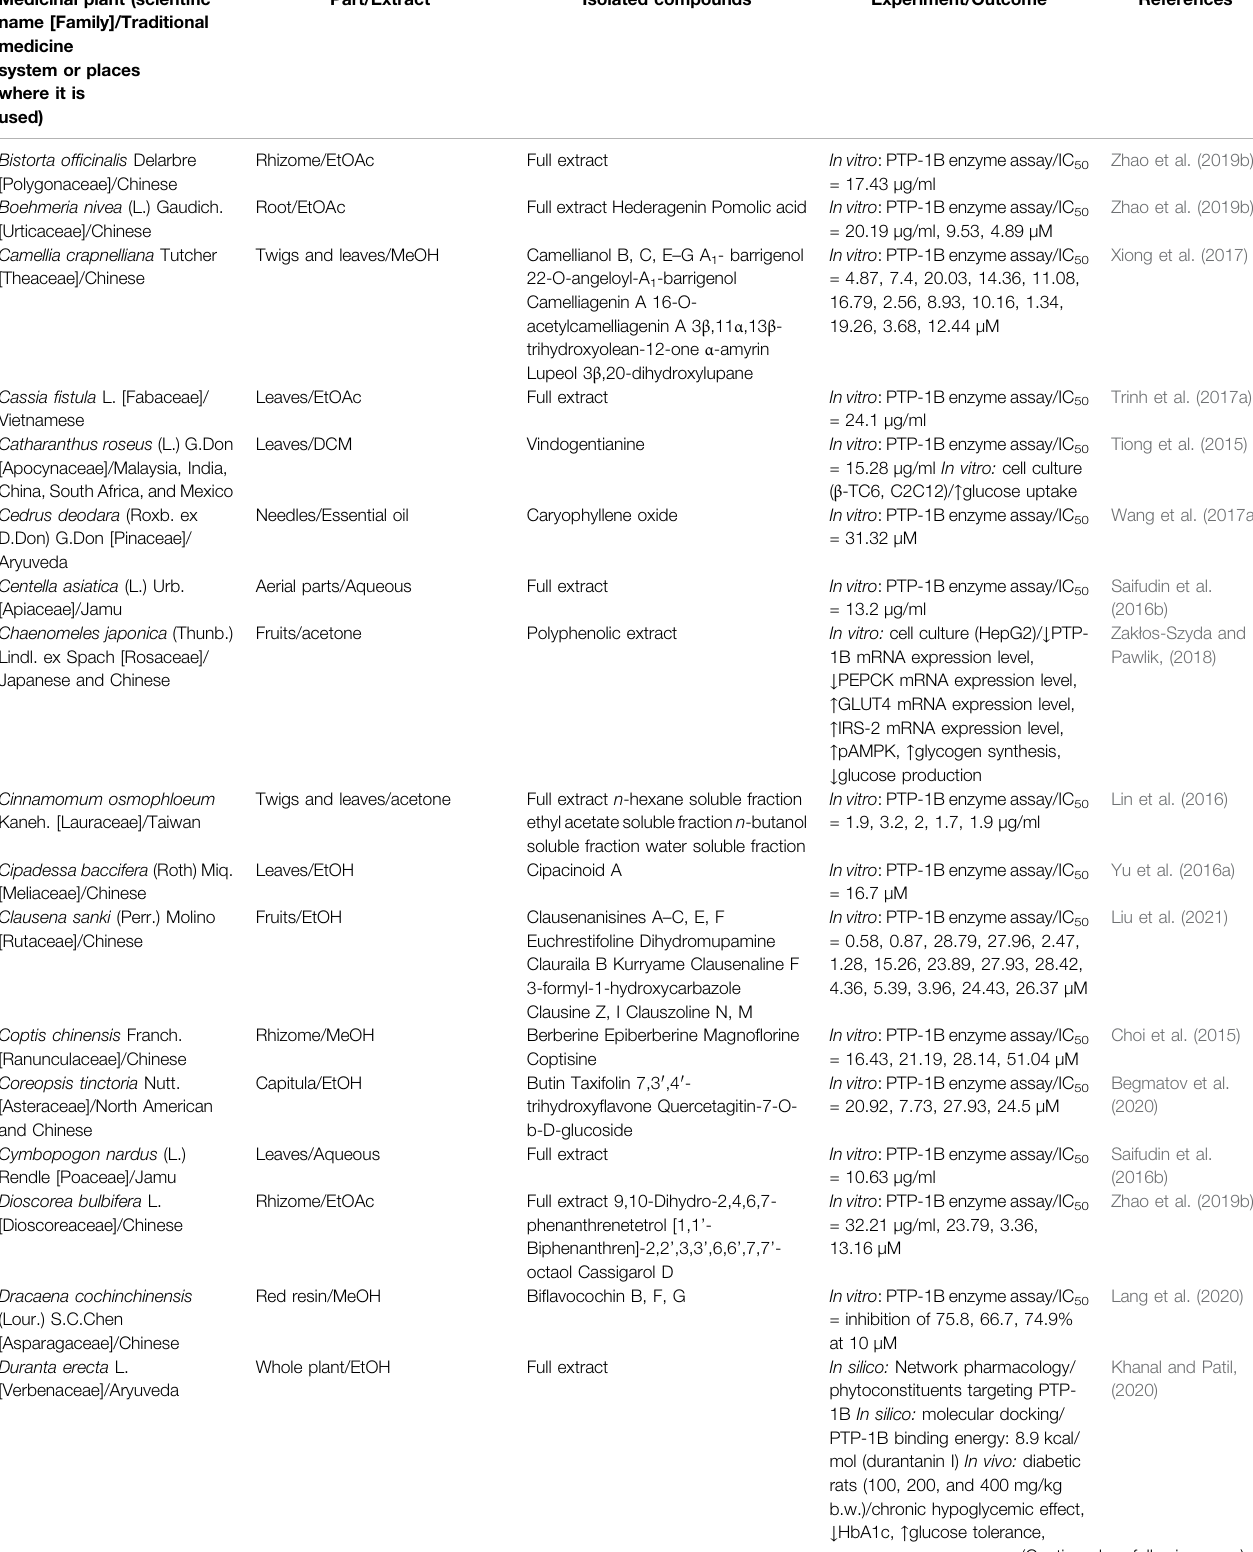
Medicinal plant (scienti fi c name